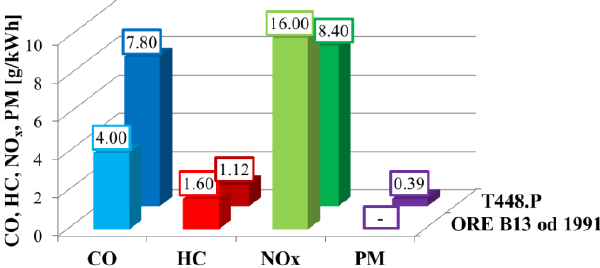
Fig. 15. Summary of test results with the limit values of harmful exhaust compounds according to ORE B13 Rp 22 in force since